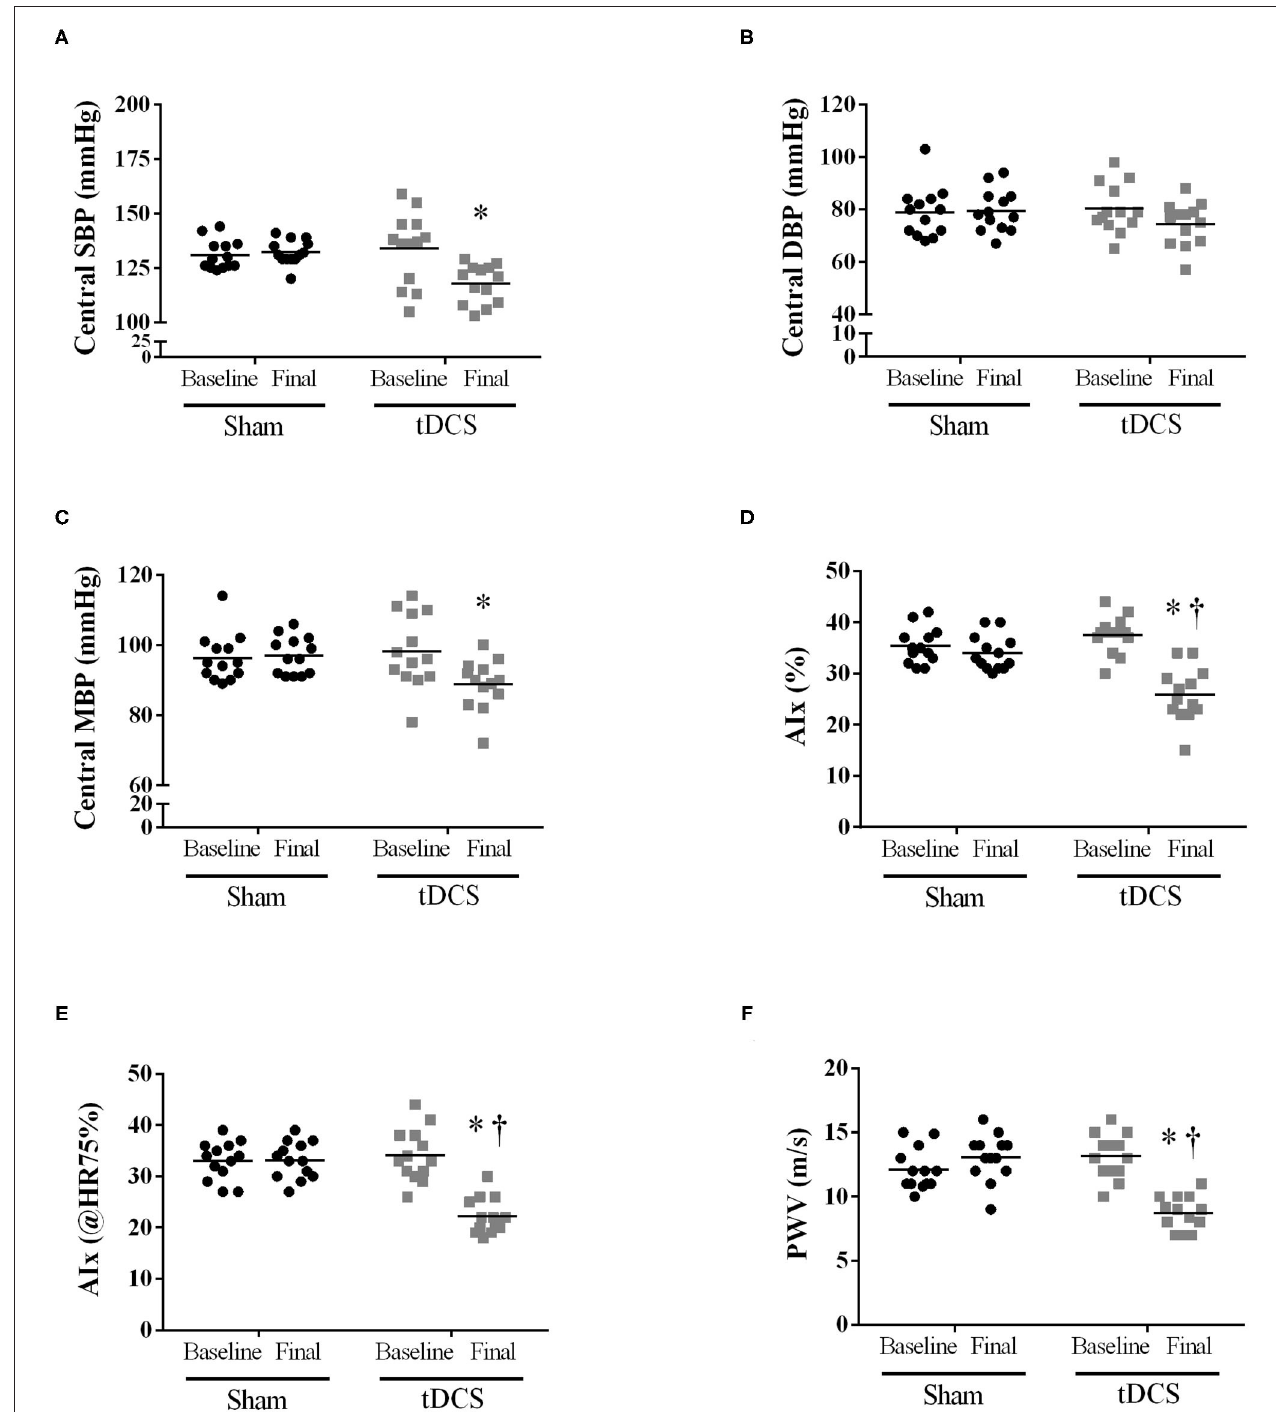
FIGURE 2 | Short-term intervention (10 sessions): Applanation tonometry method to determine whether short-term tDCS (10 sessions) could affect the central blood pressure and pulse waves behavior. (A) Central SBP [ P = 0.0225 vs. SHAM; Interaction – P = 0.0016]; (B) Central diastolic blood pressure [ p = 0.2655 vs. SHAM; Interaction – P = 0.0106]; (C) Central mean blood pressure [ P = 0.0320 vs. SHAM; Interaction – P = 0.0002]; (D) Augmentation Index (AIx) expressed in % [ P = 0.0421 vs. SHAM; Interaction – P = 0.0002]; (E) AIx normalized for a heart rate of 75 bpm [ P = 0.0010 vs. SHAM; Interaction – P < 0.0001]; (F) PWV – pulse wave velocity [ P = 0.0093 vs. SHAM; Interaction – P < 0.0001]. Repeated-measures two-way ANOVA, followed by Bonferroni post-test. *Difference vs. SHAM at final moment; † P < 0.05 vs. tDCS baseline in the same condition.